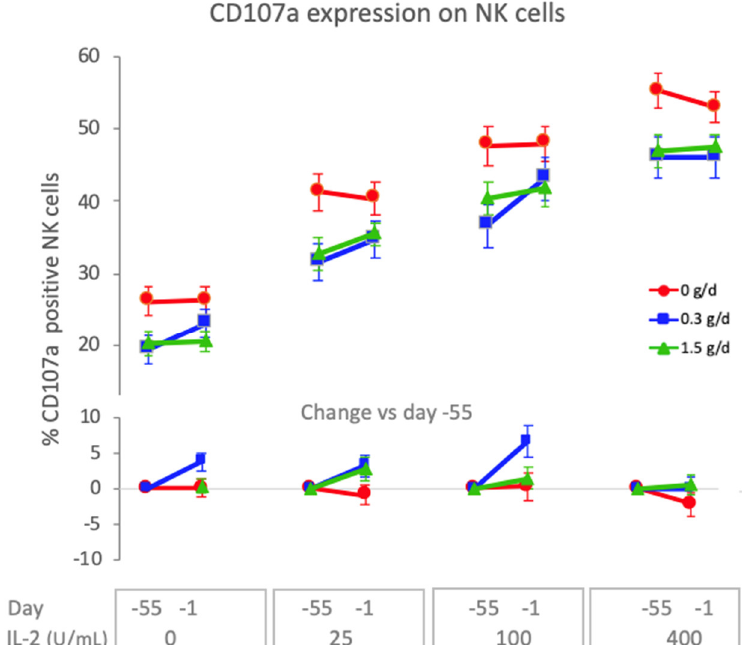
Figure 6. Expression of the activation marker CD107a on NK cells, after ex vivo incubation with K562 target cells, was significantly increased ( p < 0.001) in the cRG-I groups. Increasing concentra- tions of exogenously added IL-2 reduced this effect ( p < 0.03). Top: % of CD107a positive NK cells, and bottom: % change d-1 vs. d-55 (baseline), optimal for IL-2 concentrations 25–100 U/mL).